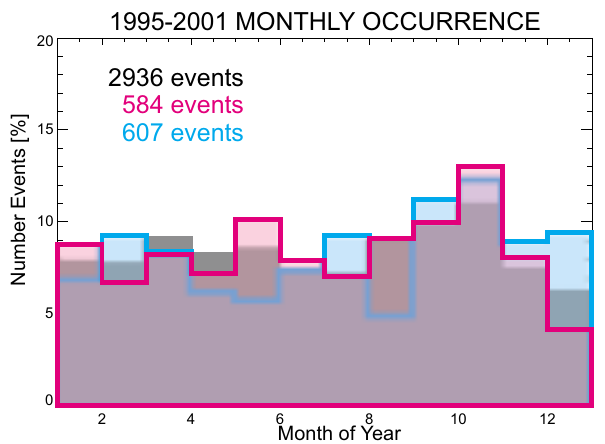
Fig. 2. Relative monthly occurrence for all events observed through 1995–2001 are displayed as the gray block diagram. Overlaid are the monthly occurrence distributions for the subgroups of large and small amplitude events drawn in magenta and cyan colors, respec- tively. The number of events in each group is written in the cor- responding color in the plot. Relative occurrence is displayed as percentage of the total number of events in each